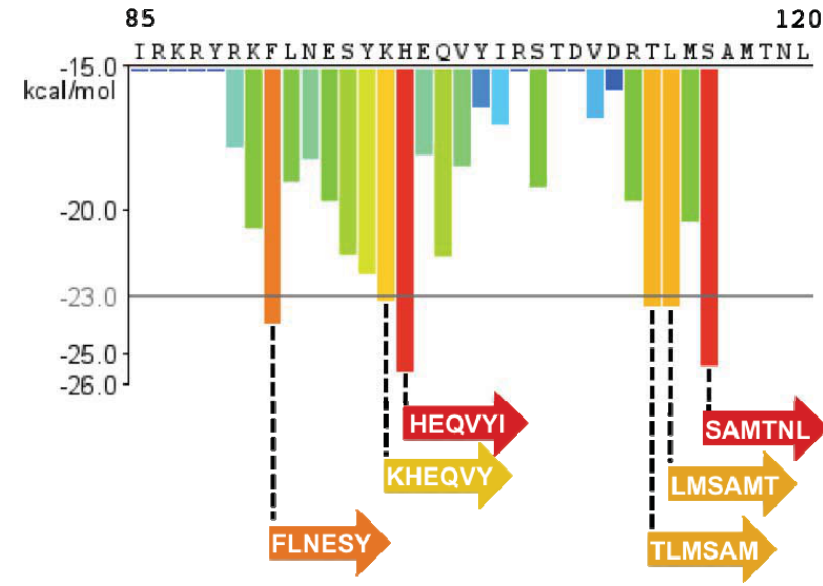
Figure 5. PAP85-120 has six regions of high amyloidogenic propensity. The Zipper DB histogram of PAP85-120 predicts six hexapeptide segments that are highly likely to form steric-zipper